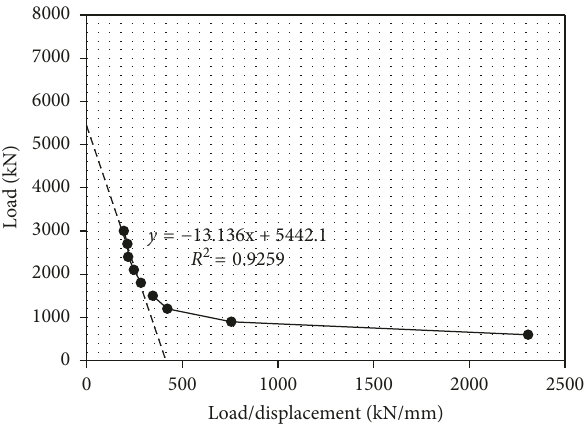
Figure 12: Uplift SLT result of P16.